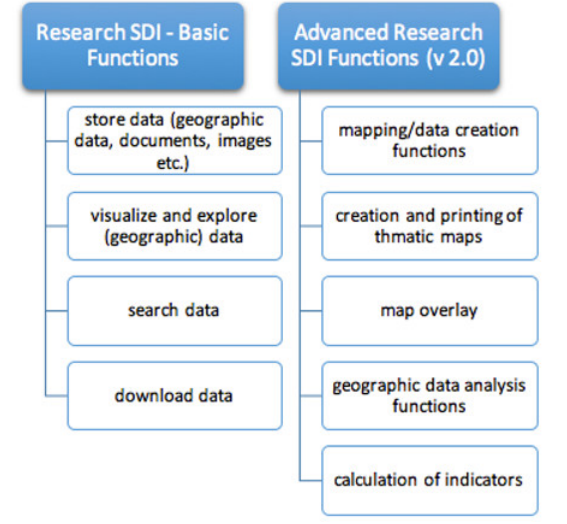
Figure 2. Desired functionality of the Research SDI, derived from responses to a potential-user survey by CEDEUS researchers.